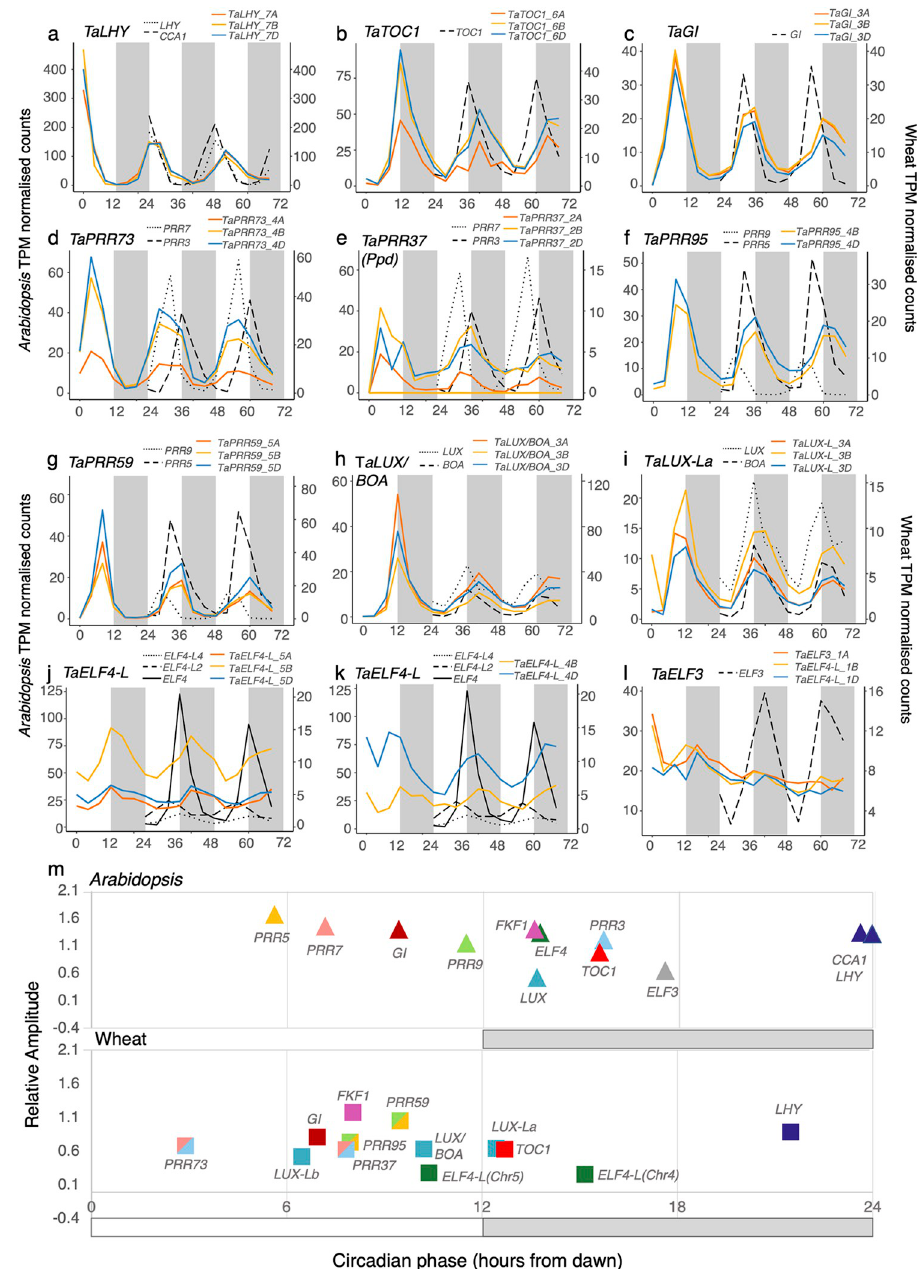
Fig 3. Free-running expression of core circadian clock genes in wheat and their homologs in Arabidopsis . (a–l) Wheat circadian clock genes were identified through alignment of phylogenetic protein family trees or BLASTP to known clock gene homologs. Gene IDs for each gene set are in S7 Table. Wheat homoeologs are coloured according to their identity to either the A genome (orange), B genome (yellow), or D genome (blue) and grey and white blocks indicate subjective dark and light time periods under constant conditions. Data represent the mean of 3 biological replicates and transcript expression is collapsed to gene level. Expression profiles for additional core circadian clock genes are in S17 Fig. Expression of Ta ELF3 transcripts were calculated by mapping to both CS and Jagger gene models for the chromosome 1D introgression shared between Jagger and Cadenza. (m) Phases of core clock genes in Arabidopsis and wheat (meta2d estimates from data 24–68 h after transfer to L:L). Genes were not plotted if BH q - values were > 0.01. Wheat values represent circular mean circadian phases (CT) across homoeologs calculated in S8 Table. (Data_Fig 3a-m in S1